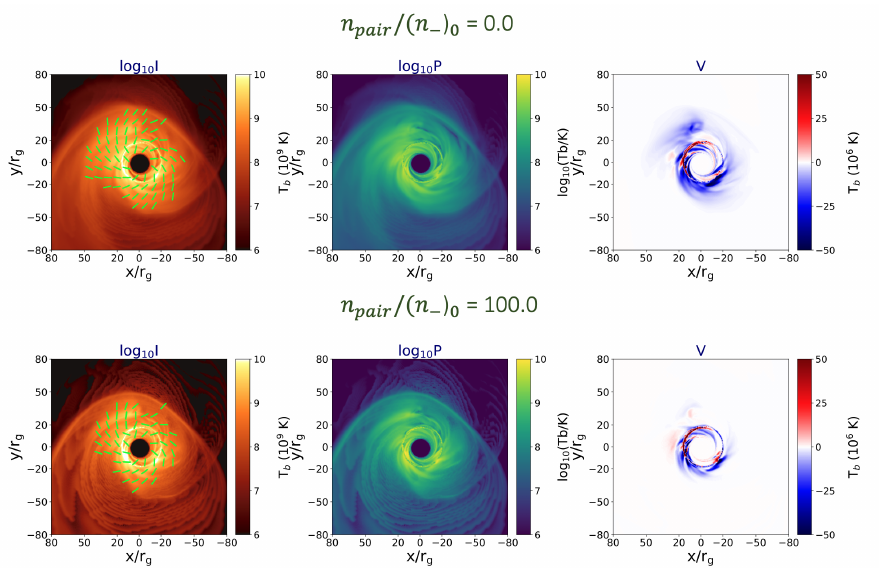
Figure 7. A map from MAD simulations with a = +0.94 at R high = 20 in R-beta model from KHARMA simulations. The top row refers to the case with no positrons while the bottom one describes the case with 100% positrons compared with the original number of electrons. In each row, from the ( left ) to ( right ), we present the images of total intensity, the linear and the circular polarization, respectively. We have used ν = 230 GHz to make these